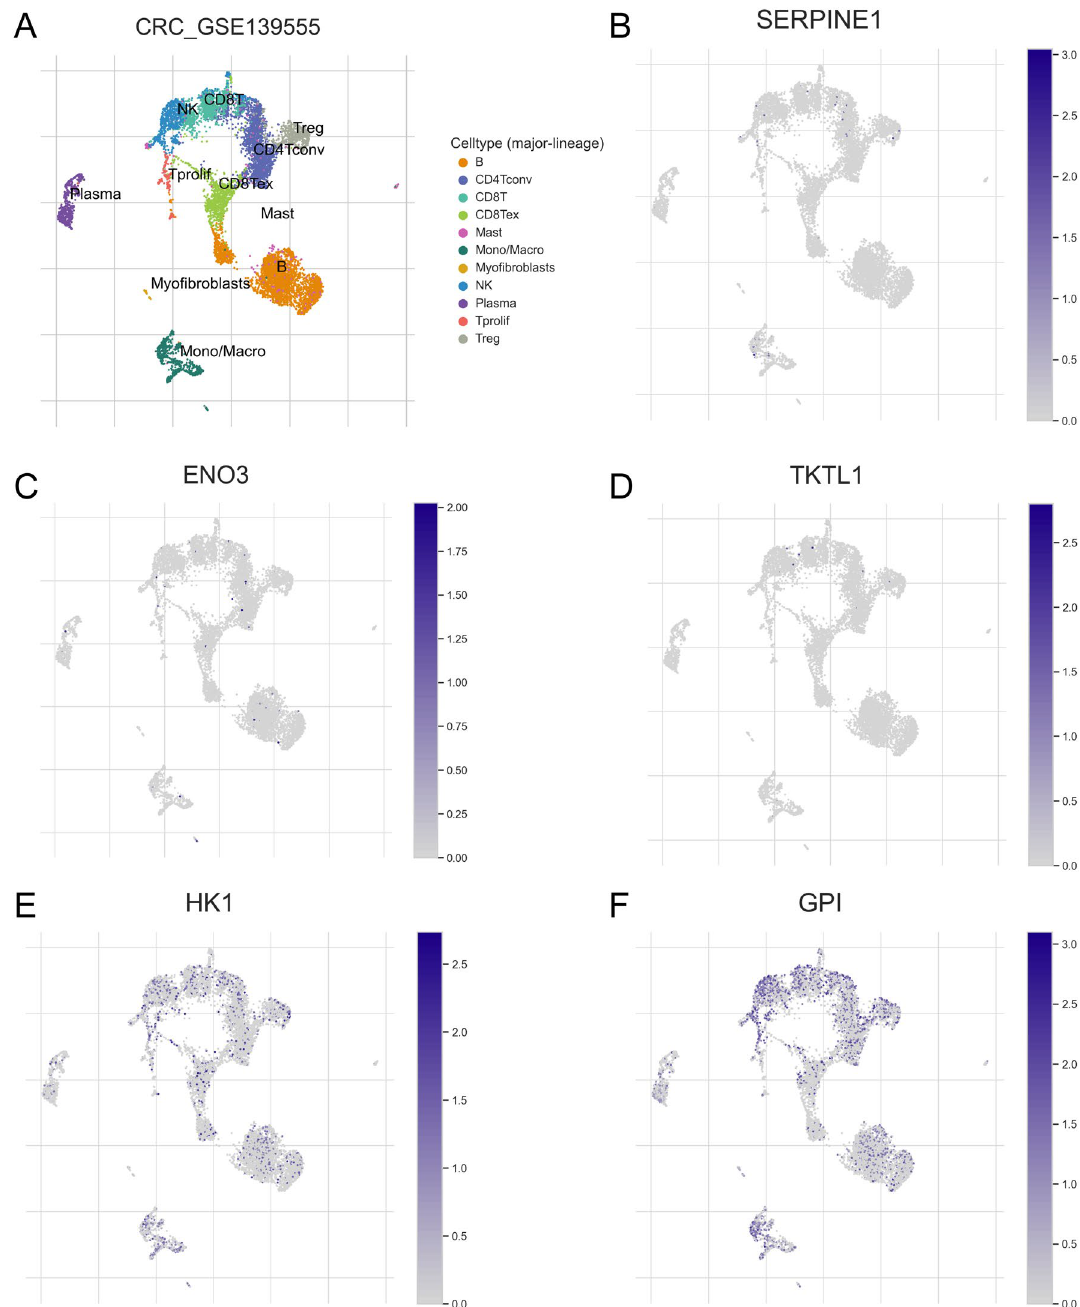
Figure 6. Single-cell RNA-seq analysis of HRGs. ( A ) The distribution of TICs by the UMAP method. The mRNA expression of ( B ) SERPINE1 , ( C ) ENO3 , ( D ) TKTL1 , ( E ) HK1 , and ( F ) GPI in the different